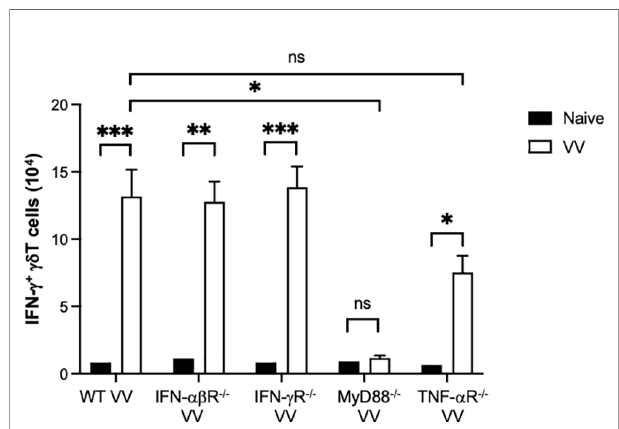
FIGURE 5 | In vivo screen for signaling pathways required for gd T cell activation following VV infection. Wild-type (WT), IFN- ab receptor de fi cient (IFN- ab R -/- ), IFN- g receptor de fi cient (IFN- g R -/- ), MyD88 de fi cient (MyD88 -/- ), and TNF- a receptor de fi cient (TNF- a R -/- ) mice were inoculated with VV intraperitoneally and splenocytes were harvested 4 days after inoculation. Harvested cells were gated for CD3e + gd TCR + T cells and subsequently assessed IFN- g positivity. Unpaired